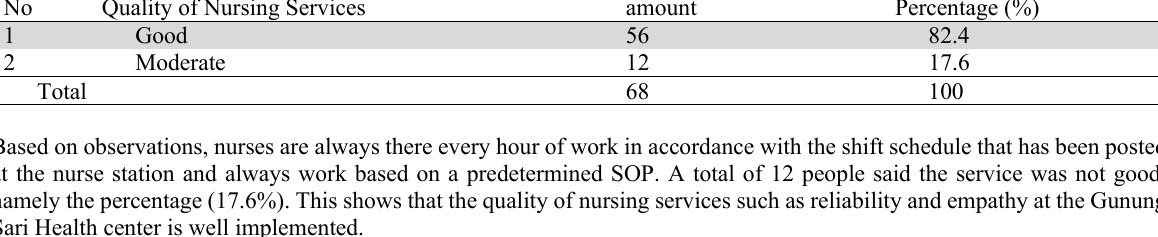
Distribution of respondents' responses based on the quality of nursing services No Quality of Nursing Services amount Percentage (%) Good